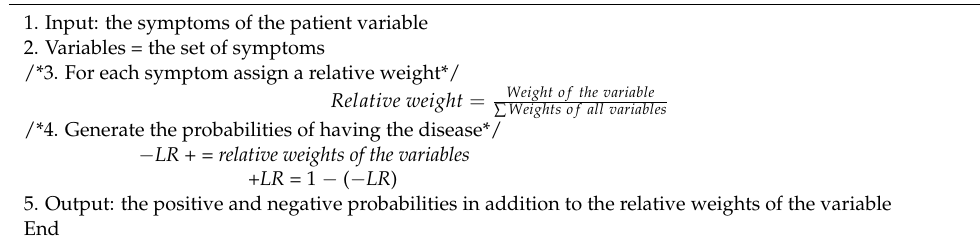
Algorithm 2: Interpretability algorithm for training the dataset of the rules-based models